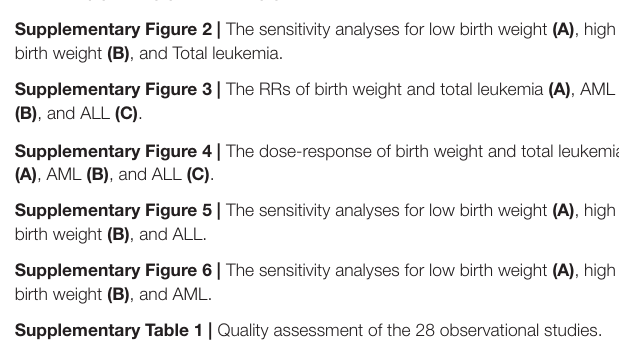
Supplementary Figure 1 | The plots of the funnel for birth weight and Total leukemia (A) , ALL (B) , and AML (C) . Supplementary Figure 2 | The sensitivity analyses for low birth weight (A) , high birth weight (B) , and Total leukemia. Supplementary Figure 3 | The RRs of birth weight and total leukemia (A) , AML (B) , and ALL (C) . Supplementary Figure 4 | The dose-response of birth weight and total leukemia (A) , AML (B) , and ALL (C) . Supplementary Figure 5 | The sensitivity analyses for low birth weight (A) , high birth weight (B) , and ALL. Supplementary Figure 6 | The sensitivity analyses for low birth weight (A) , high birth weight (B) , and AML. Supplementary Table 1 | Quality assessment of the 28 observational